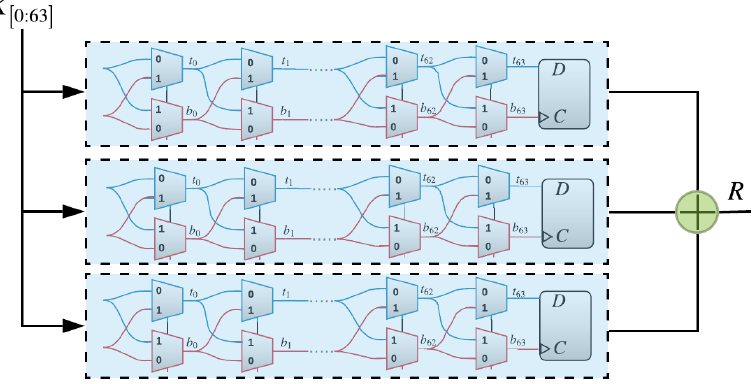
Figure 2. A 3-XOR PUF, which consists of three arbiter PUFs whose outputs are XORed to generate the final response of the XOR Arbiter PUFs (XOR